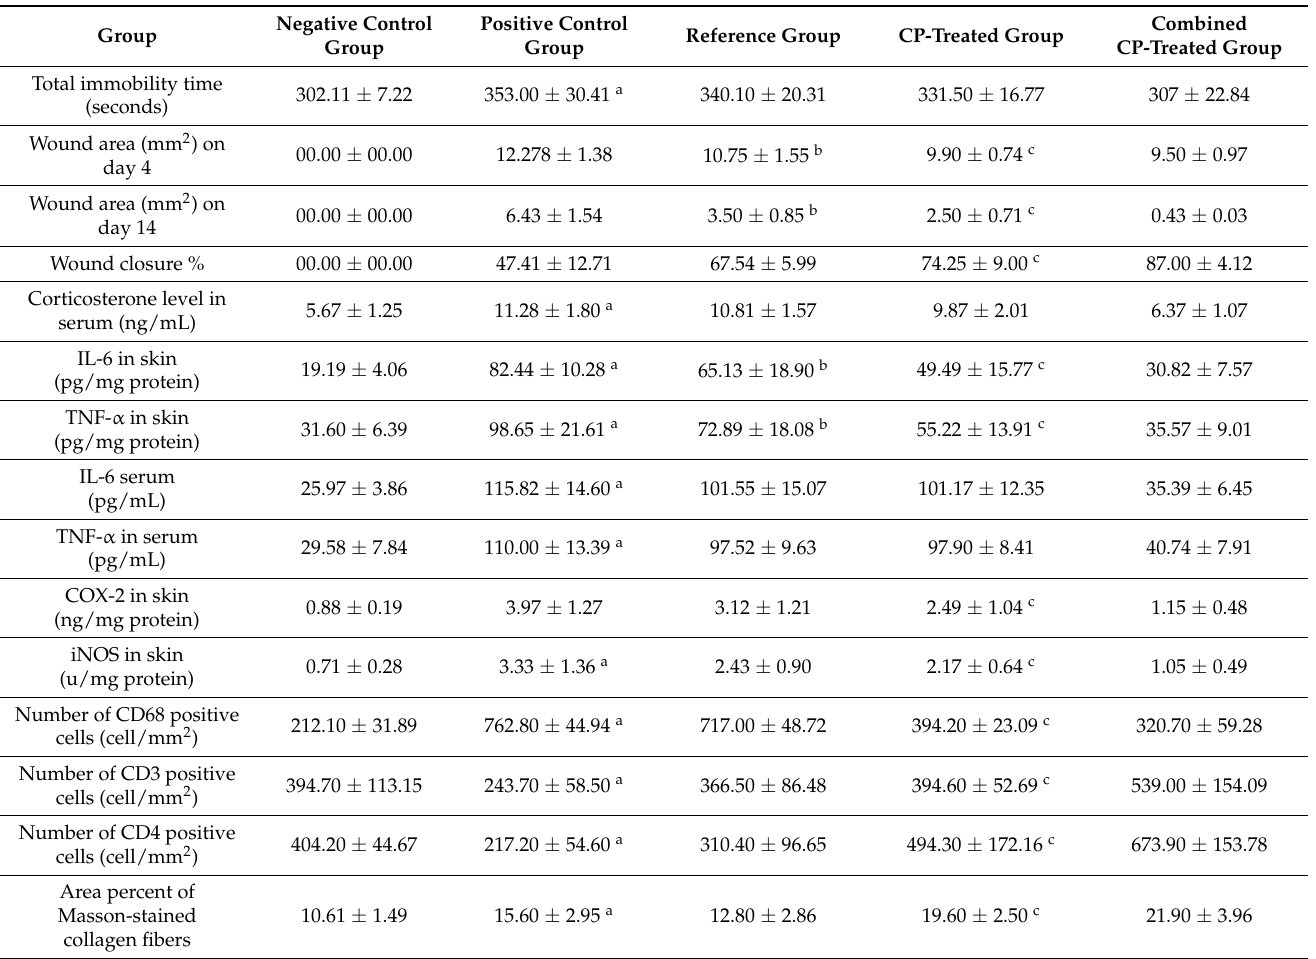
Table 1. The effect of CP administration on behavioral changes, wound closure percentage, corticos- terone, pro-inflammatory cytokines, and immune cell count.